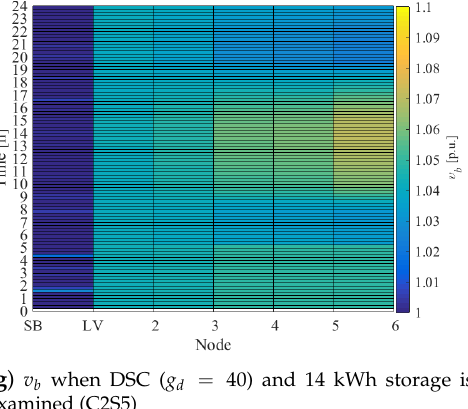
Figure 5. Voltage profile of phase b during an entire day when the positive-sequence and three-phase damping (under two values of g d ) control strategies and storage capacities are